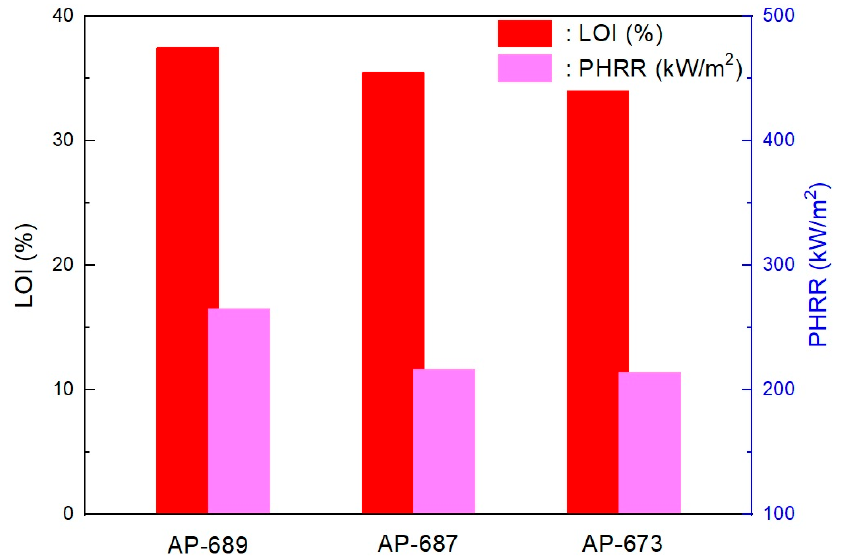
Figure 14. Relationships between LOI and PHRR in EBM content formulations. EBM content: AP-689 = 1 phr, AP-687 = 5 phr and AP-689 = 9 phr.